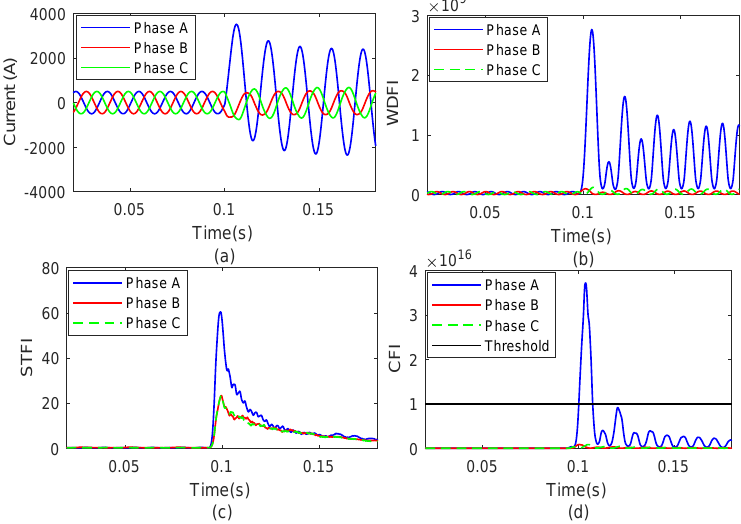
Figure 12. Detection of AG fault on node 675 in noisy environment ( a ) current waveform ( b ) WDFI ( c ) STFI ( d ) CFI.